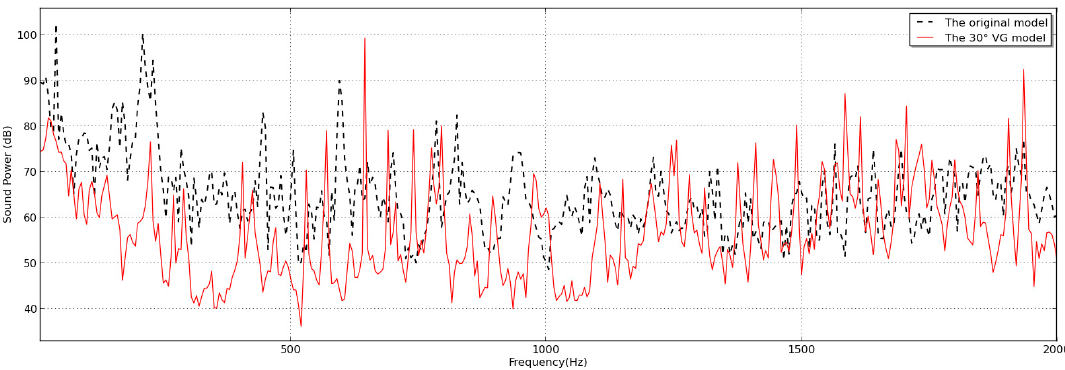
Figure 11. The curve of radiated sound power from the original model and the model with triangular VGs at the angle of 30° to the flow direction.